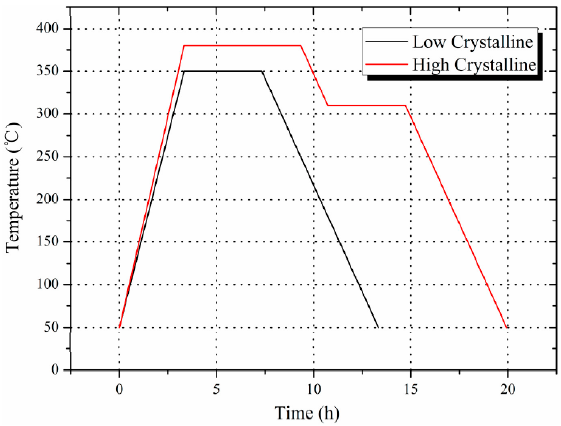
Figure 1. The sintering procedure of low and high crystalline Al-PTFE samples.